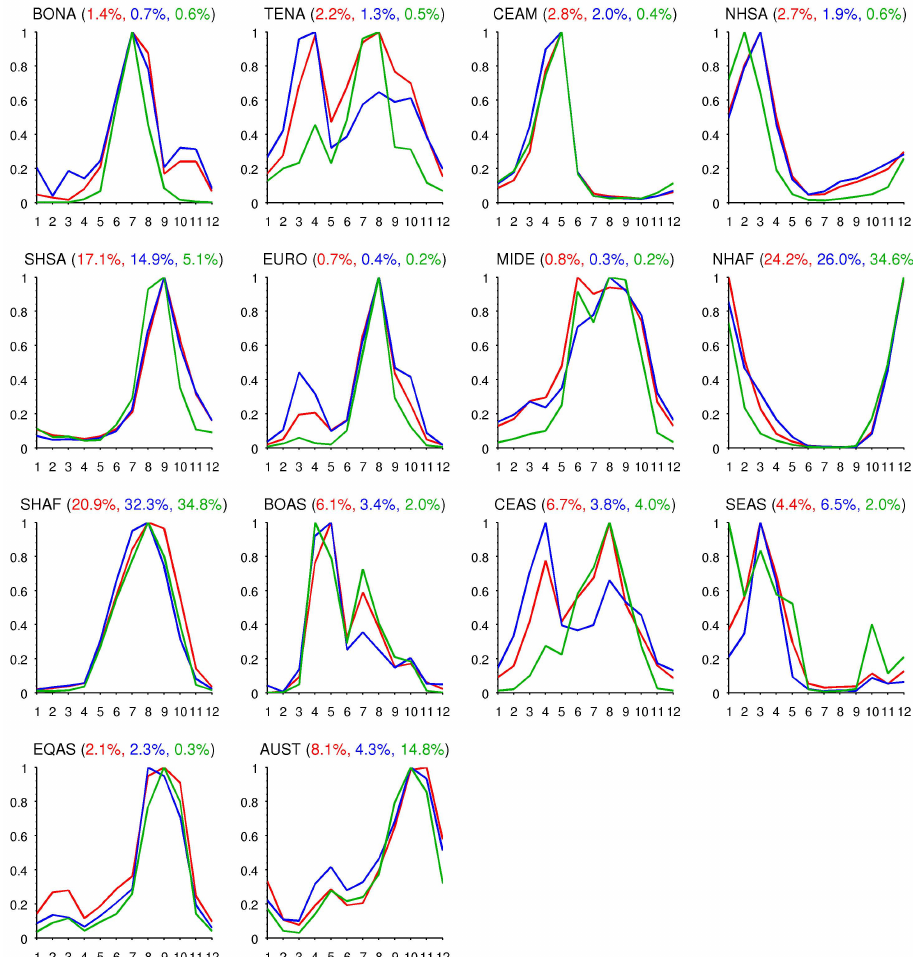
Fig. 2. Burned area from GFED (green) and fire counts from Terra MODIS (red) and Aqua MODIS (blue) for the regions in Fig. 1, normalized to the month of maximum burned area or fire counts. The x-axis shows months, while the y-axis shows the scaled burned area and fire counts. The numbers in parentheses are the percent contributions of the total mean annual fire counts or burned area in the region to the global total mean annual fire counts or burned area, following the same color scheme as the lines in the